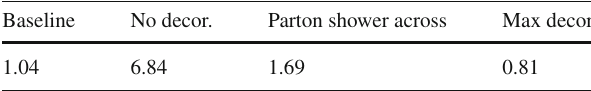
Table 4 χ 2 / N pts for the ATLAS 8 TeV differential top data, with α S free, in the lepton+jet channel. Results for different correlation scenar- ios, explained in the text, are given